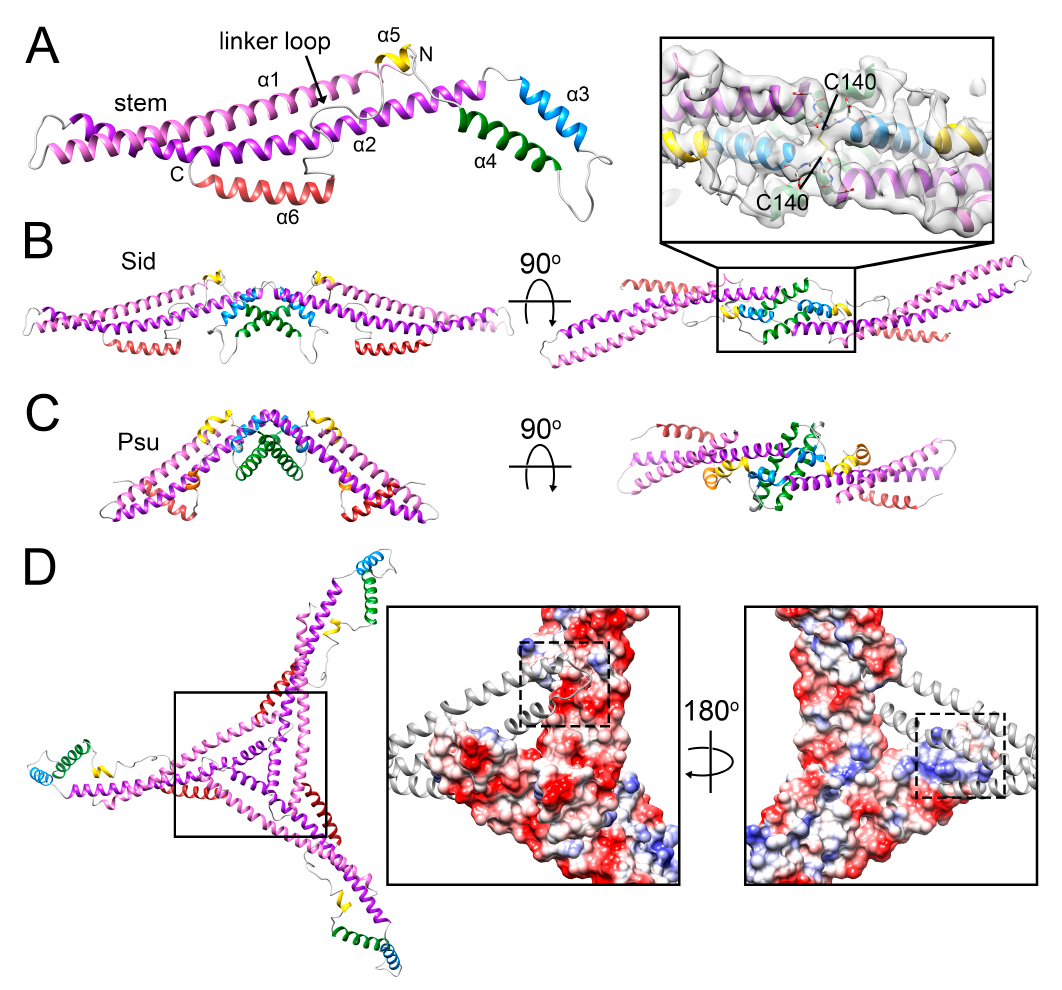
Figure 4. The Sid sca ff old. ( A ) Ribbon diagram for one monomer of Sid. Relevant structural features are labeled. ( B ) Ribbon diagram of the Sid dimer, viewed from the side, perpendicular to the twofold axis (left) and from the top, looking down the twofold axis (right). Inset: detail of the twofold interaction that includes the disulfide bond (C140). The map is shown as a transparent gray isosurface. ( C ) The Psu dimer (PDB ID: 3RX6) [45], viewed perpendicular to (left) and down (right) the twofold axis. ( D ) Ribbon diagram of the Sid trimer, viewed down the icosahedral threefold axis. The insets on the right show details of the threefold interaction. Two Sid subunits are shown as electrostatic surfaces, with the third subunit as a ribbon diagram. The left panel shows the view from the outside of the capsid, while the right panel is viewed from the inside. The surfaces that interact are indicated by the dashed